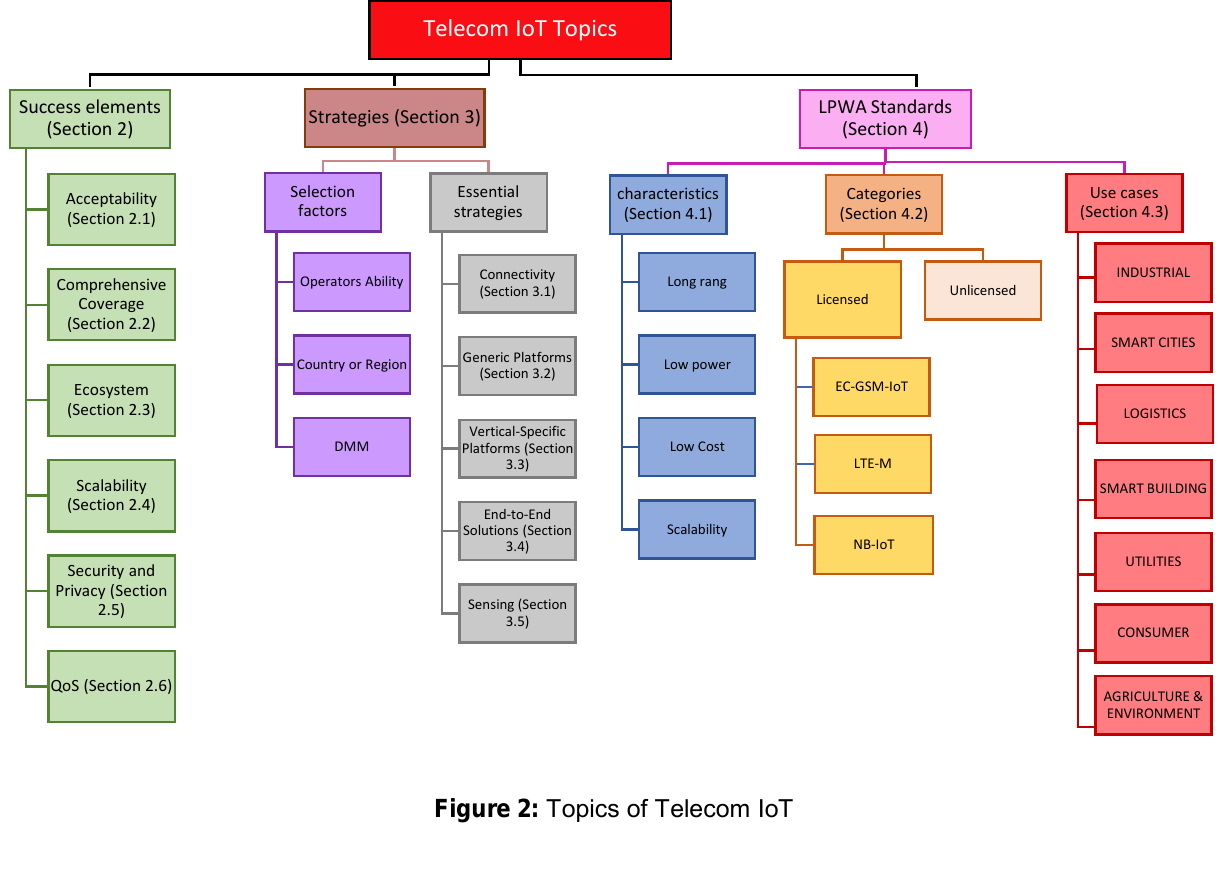
Figure 2: Topics of Telecom